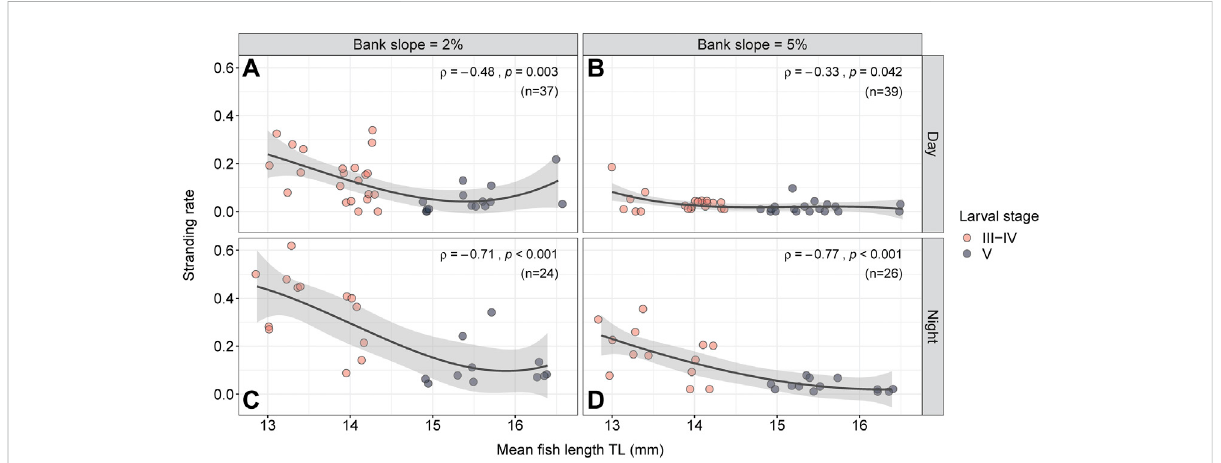
FIGURE 6 Stranding rate depending on mean fi sh length for 2% (A,C) and 5% (B,D) bank slope, both during day (A,B) and during night (C,D) with the number of replicates (n) per setup combination. The red dots represent trials with larval stage III-IV, the gray dots represent trials with larval stage V. Trends in stranding rate are indicated by the black polynomial lines with the gray shading marking the con fi dence interval (95%